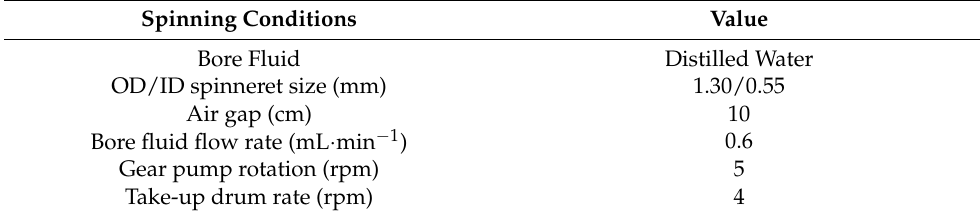
Table 2. Composition of dope solution hollow fiber